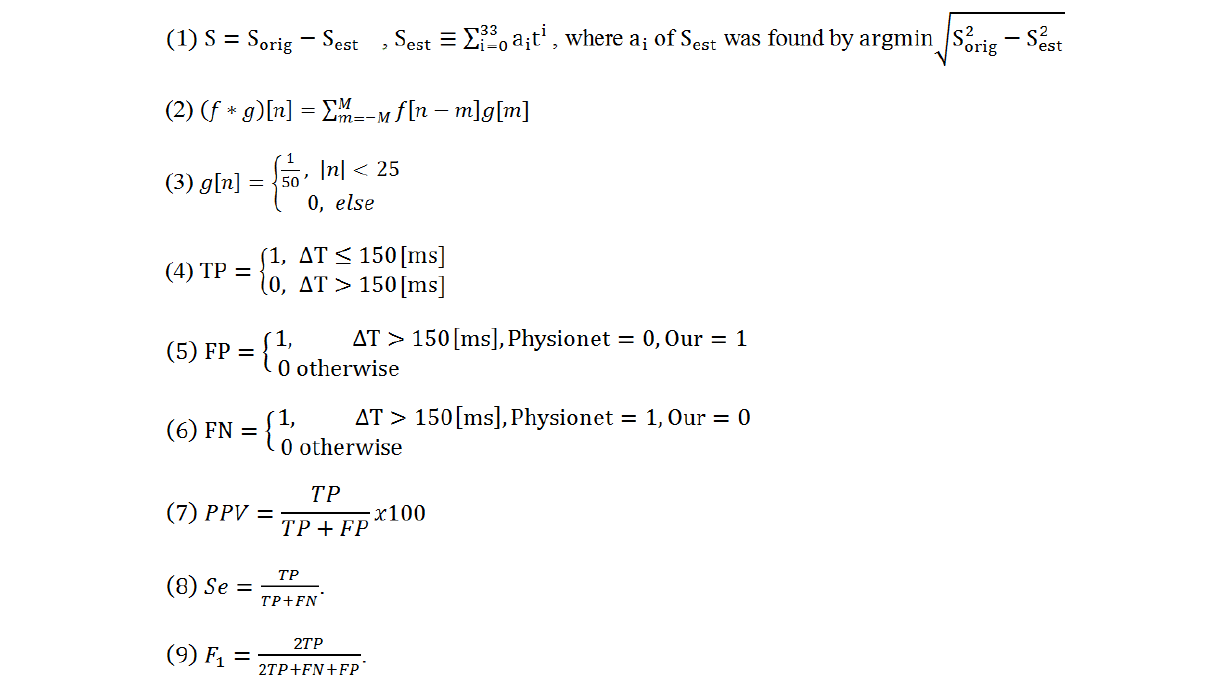
Figure 3. Equations. FN: false negative; FP: false positive; TN: true negative; TP: true positive; PPV:positive predictive value; Se: Sensitivity; Balanced F score